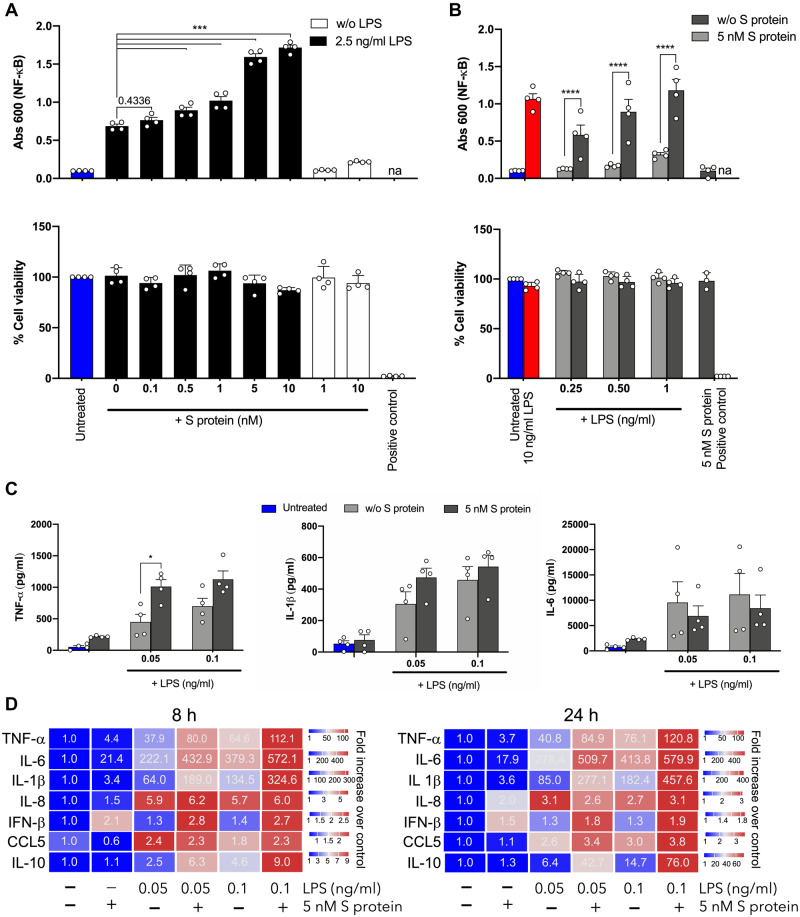
Effects of SARS-CoV-2 S protein on LPS-induced responses in THP-1 cells. (A and B) THP-1-XBlue-CD14 cells were treated with increasing concentrations of SARS-CoV-2 S protein (0‒10 nM) and a constant dose of LPS (2.5 ng/ml) (A) or with increasing doses of LPS (0.25‒1 ng/ml) and constant amount of S protein (5 nM) (B). MTT viability assay for analysis of toxic effects of S protein and LPS on THP-1 cells is shown in lower panels. (C) Cytokine analysis of the blood collected from healthy donors at 24 h after treatment with S protein with or without 0.05 and 0.1 ng/ml LPS. Untreated blood was used as a control. The mean ± SEM (NF-κB and blood assays) or mean ± SD (MTT assay) values of four independent experiments performed in duplicate are shown (n = 4). *P ≤ 0.05, ***P ≤ 0.001, ****P ≤ 0.0001, determined using two-way ANOVA with Sidak’s multiple comparisons test (NF-κB and blood assays) or one-way ANOVA with Dunnett’s multiple comparison test (MTT assay). na, not analyzed; w/o, without. (D) Heatmap showing cytokines released from PBMCs, isolated from three different donors and treated with SARS-CoV-2 S protein (5 nM) and increasing doses of LPS (0.05‒0.1 ng/ml) for 8 and 24 h. The cytokines were detected by Luminex multiplex bead assay. Color and values in each box represent mean values of fold increase over untreated cells (n = 3).